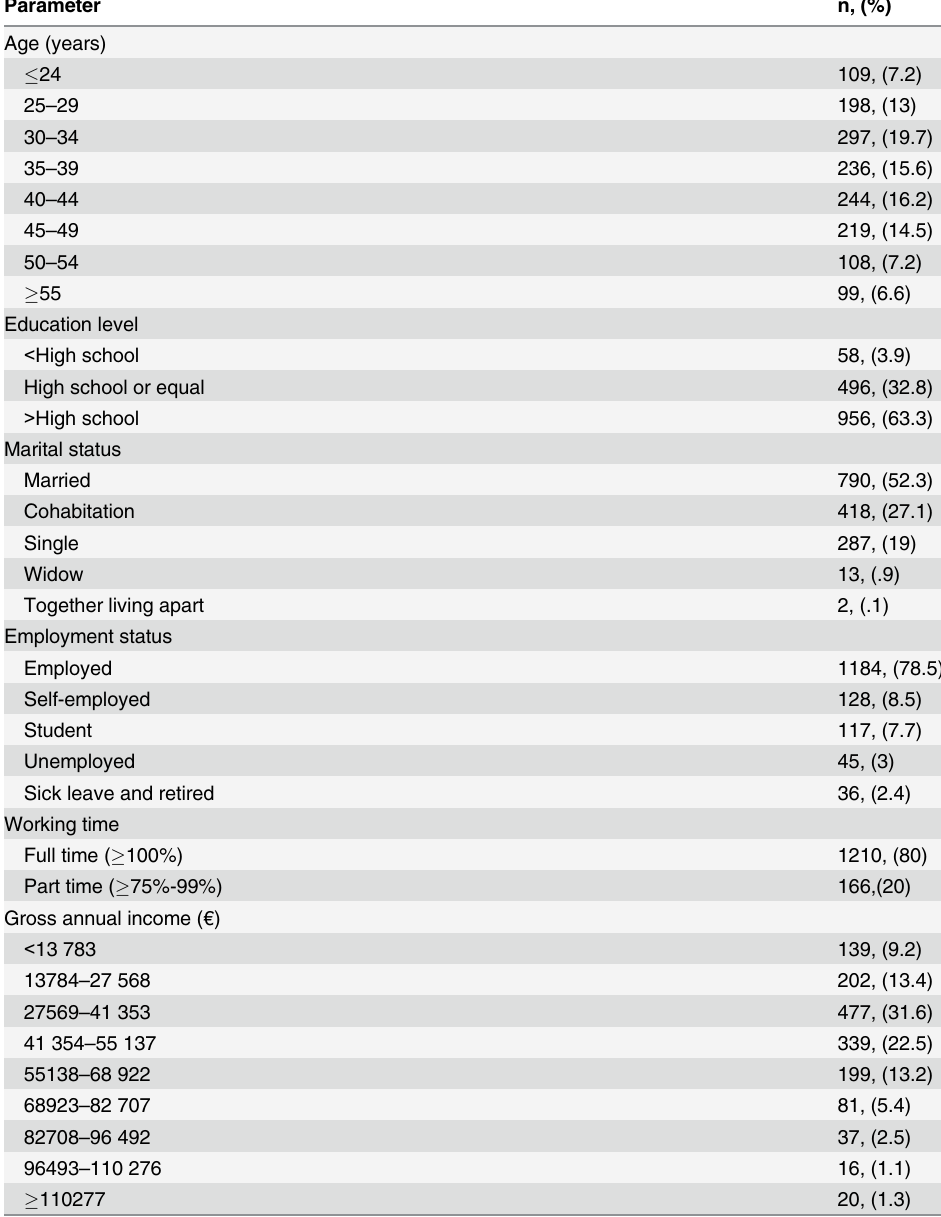
Table 1. Sociodemographic characteristics of 1510 women attending the clinic-based cervical cancer screening program in Sweden. Parameter n,